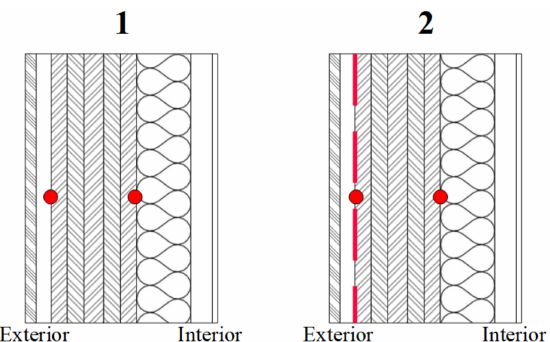
Figure 8. Wall assembly with internal insulation. No WRB modelled (Case 1), and WRB adhered to exterior of CLT panel (Case 2). Red points represent the monitoring positions at the internal and external surface of the CLT